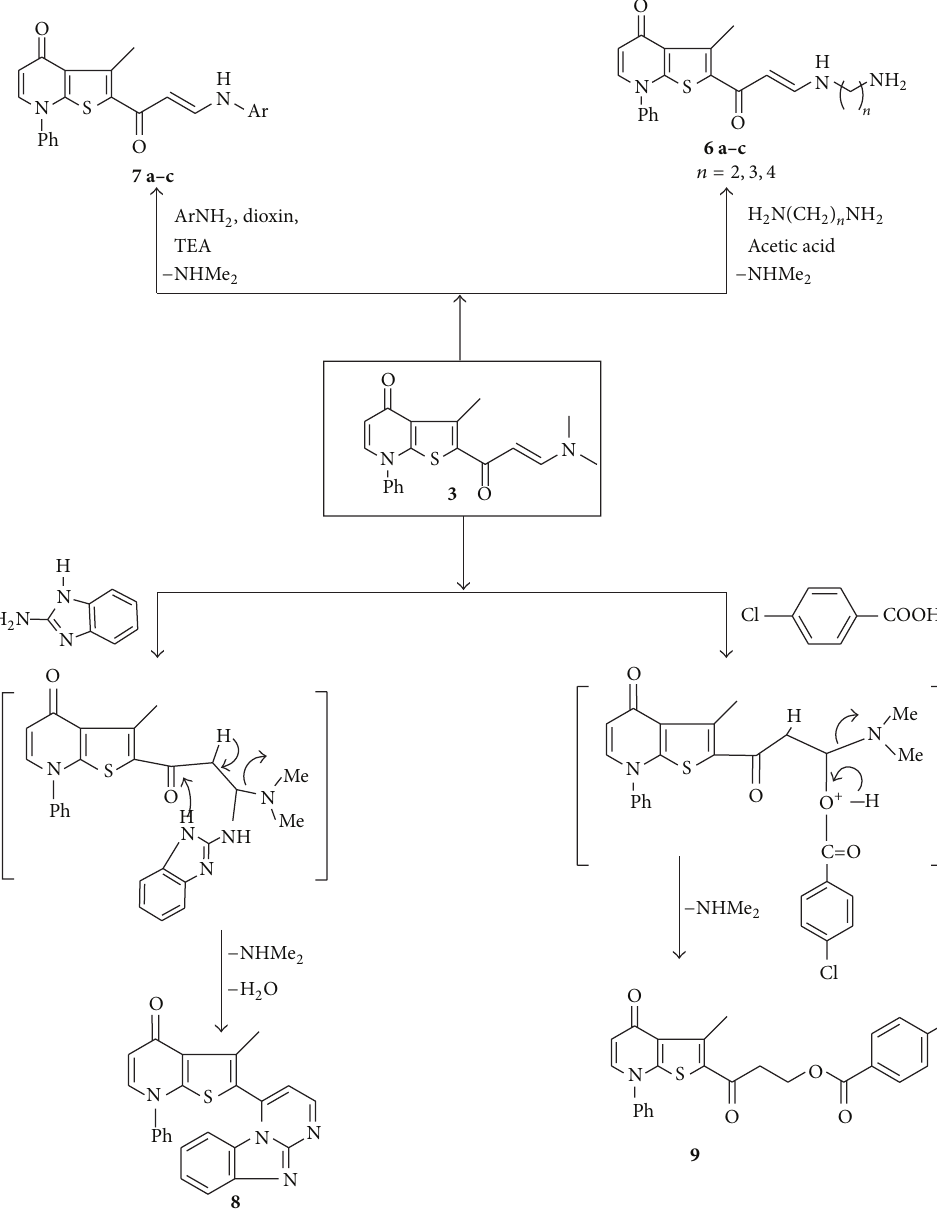
Scheme 3: Synthesis of compounds 6 – 9